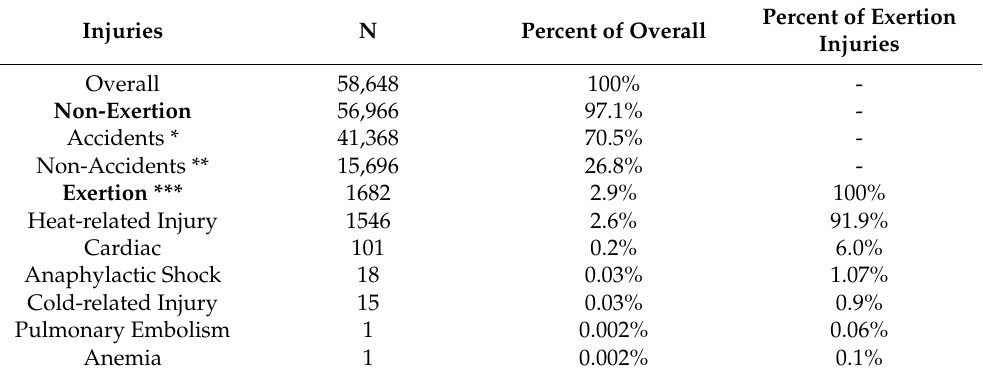
Table 1. Nature of OSHA reported exertion-related and non-exertion-related injuries in OSHA Severe Injury Report (2015–2020).